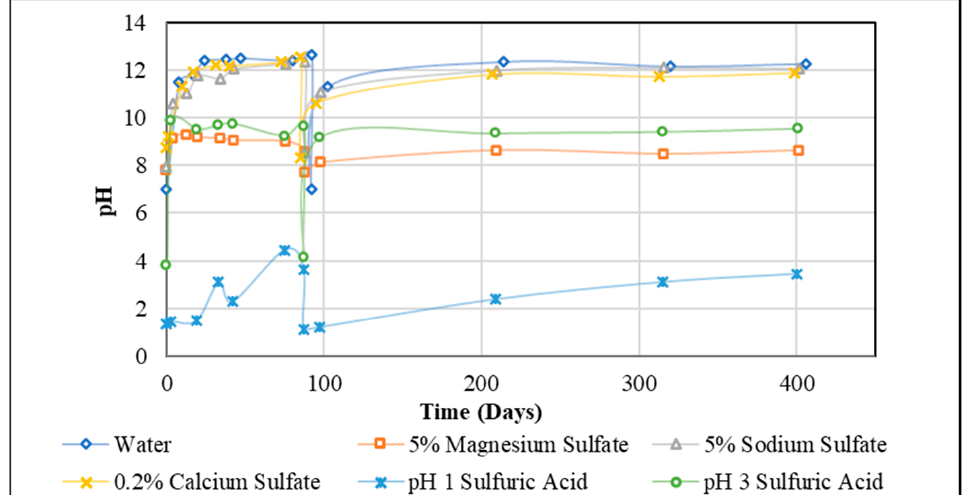
Figure 1. The fluctuation of the pH value of water, MgSO 4 , Na 2 SO 4 , CaSO 4 , and sulphuric acid solutions over 400 days of exposure to concrete specimens. Results represent an average of both Group 1 and Group 2 specimens containing AASC and AAS/F blends.